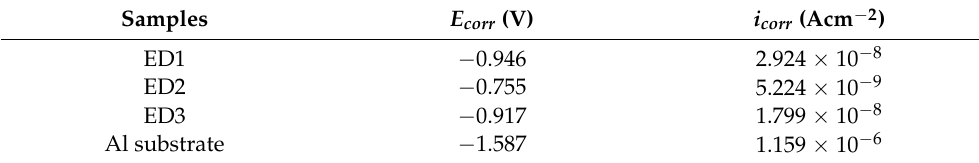
Figure 7. Anti-corrosion test: ( a ) the potentiodynamic polarization curves of the samples; ( b ) the immersion experiment of the ED2 sample. Table 1. The corresponding polarization parameters of Al substrate and ED1, ED2 and ED3